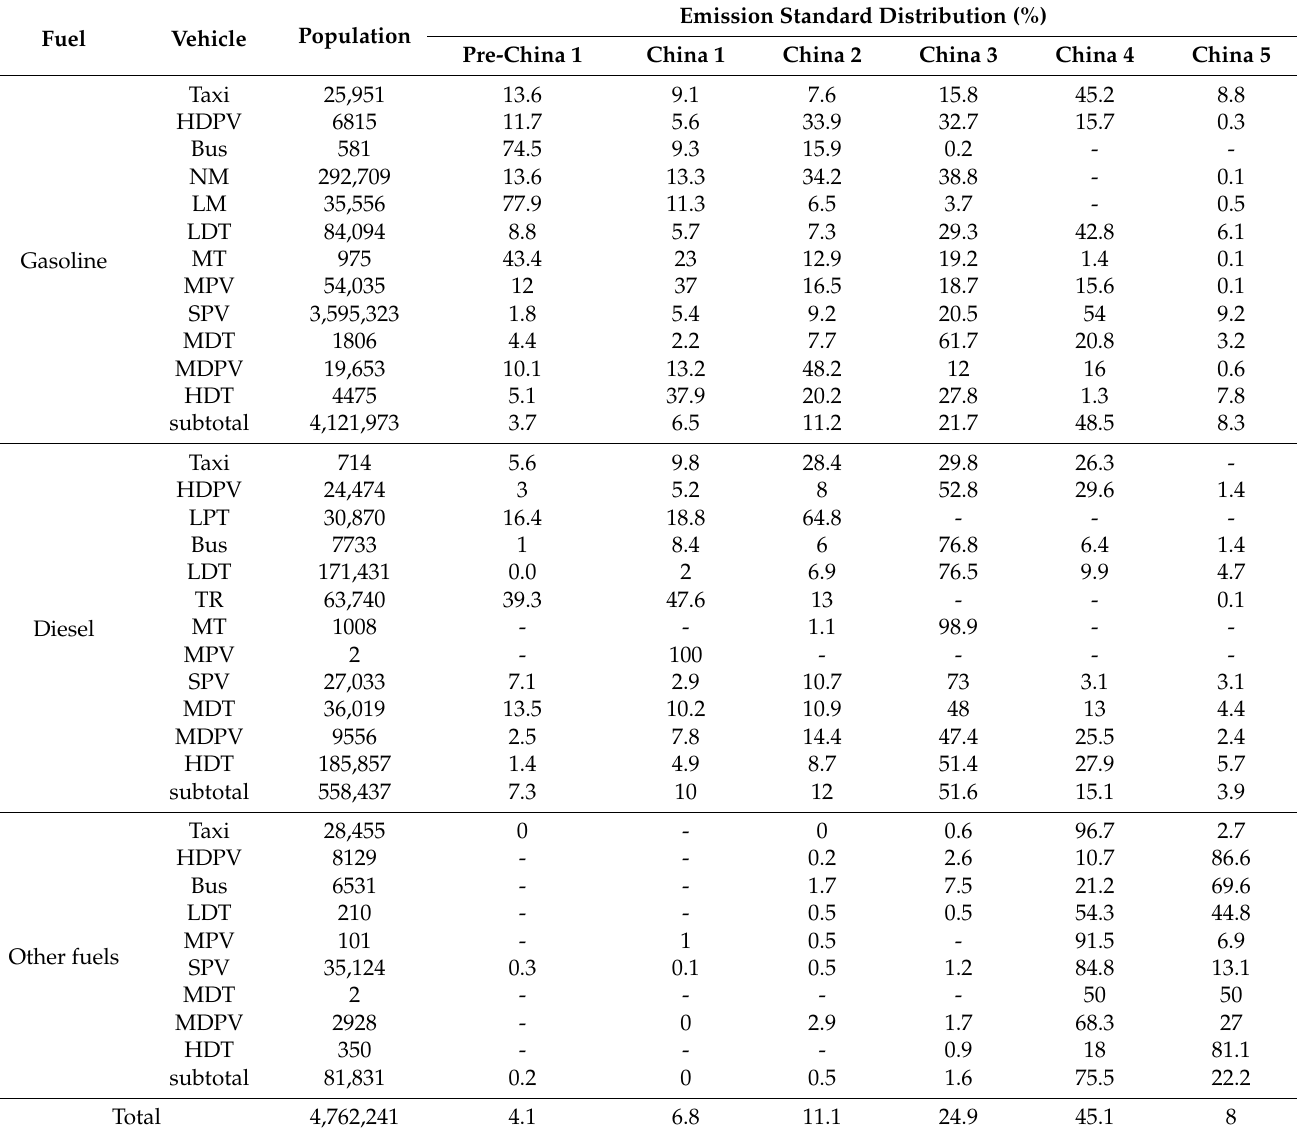
Table 2. Quantities of the different vehicle types and national vehicular emission limit standards in the CLUA region during